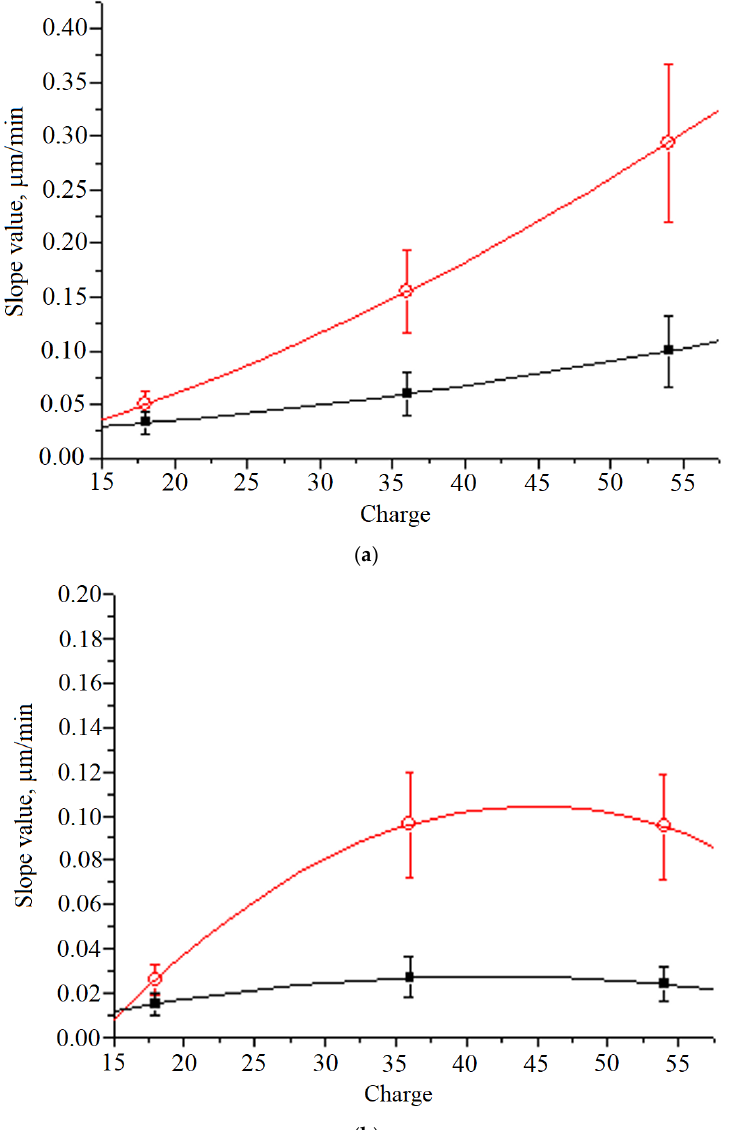
Figure 4. Dependence of the slope factors (rates of change in the track dimensions) on the ion charge for large (red line) and small (black line) axis of the ellipses: ( a ) the etching duration from 30 to 45 min; ( b ) the etching duration more than 50 min. The experimental points are approximated with parabolas (Color).